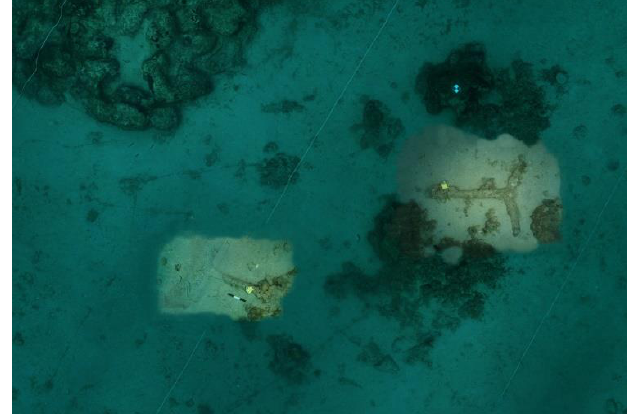
Figure 6a: Orthophotomosaic of concentration area and finds